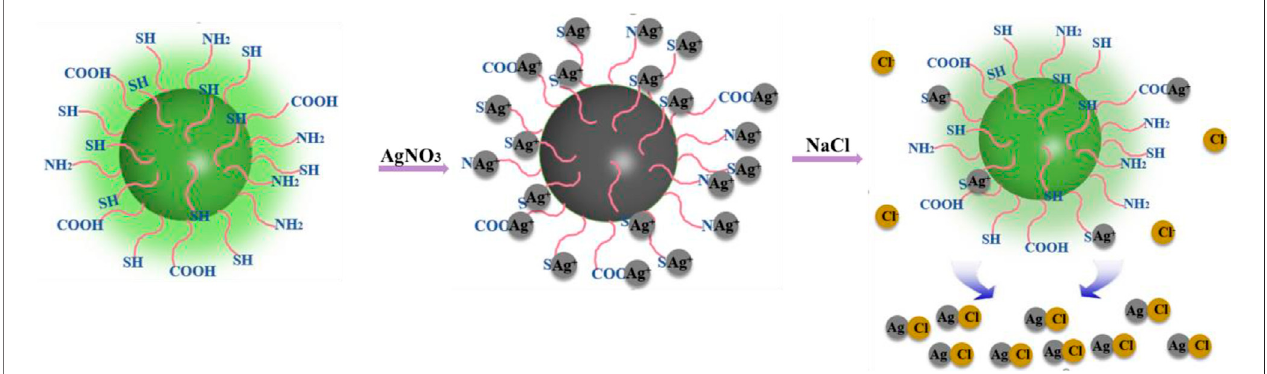
FIGURE 5 | Schematic diagram of CD fl uorescence quenching and